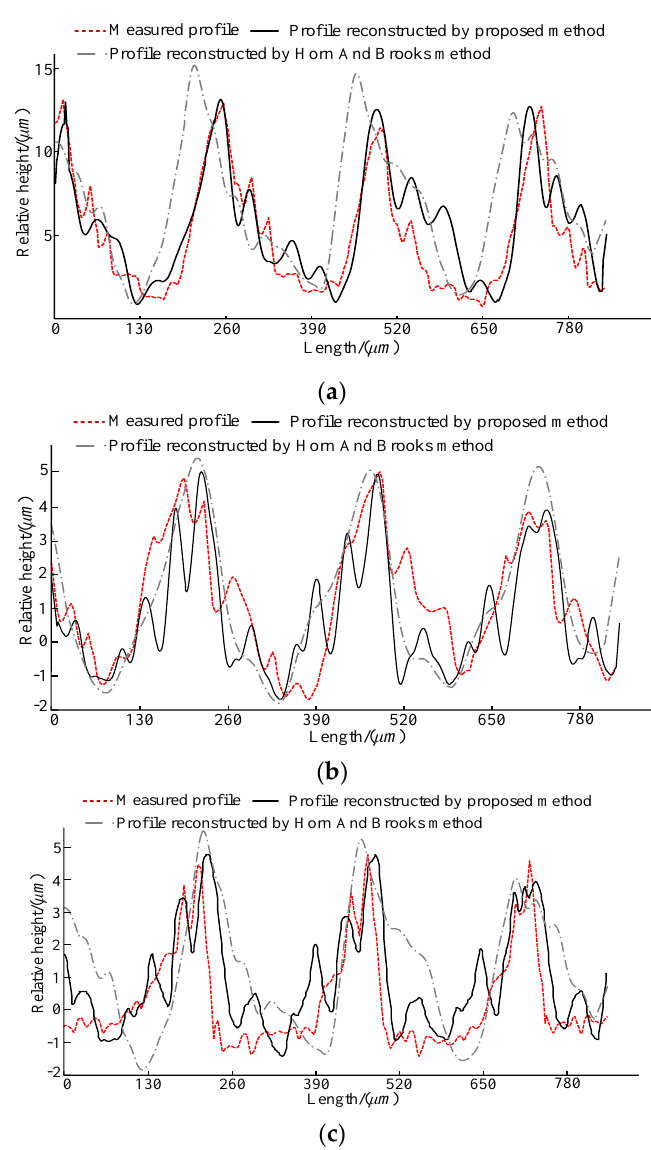
Figure 14. Comparison of measured and reconstructed profiles: ( a ) Turing surface; ( b ) Milling surface; and ( c ) Boring surface.